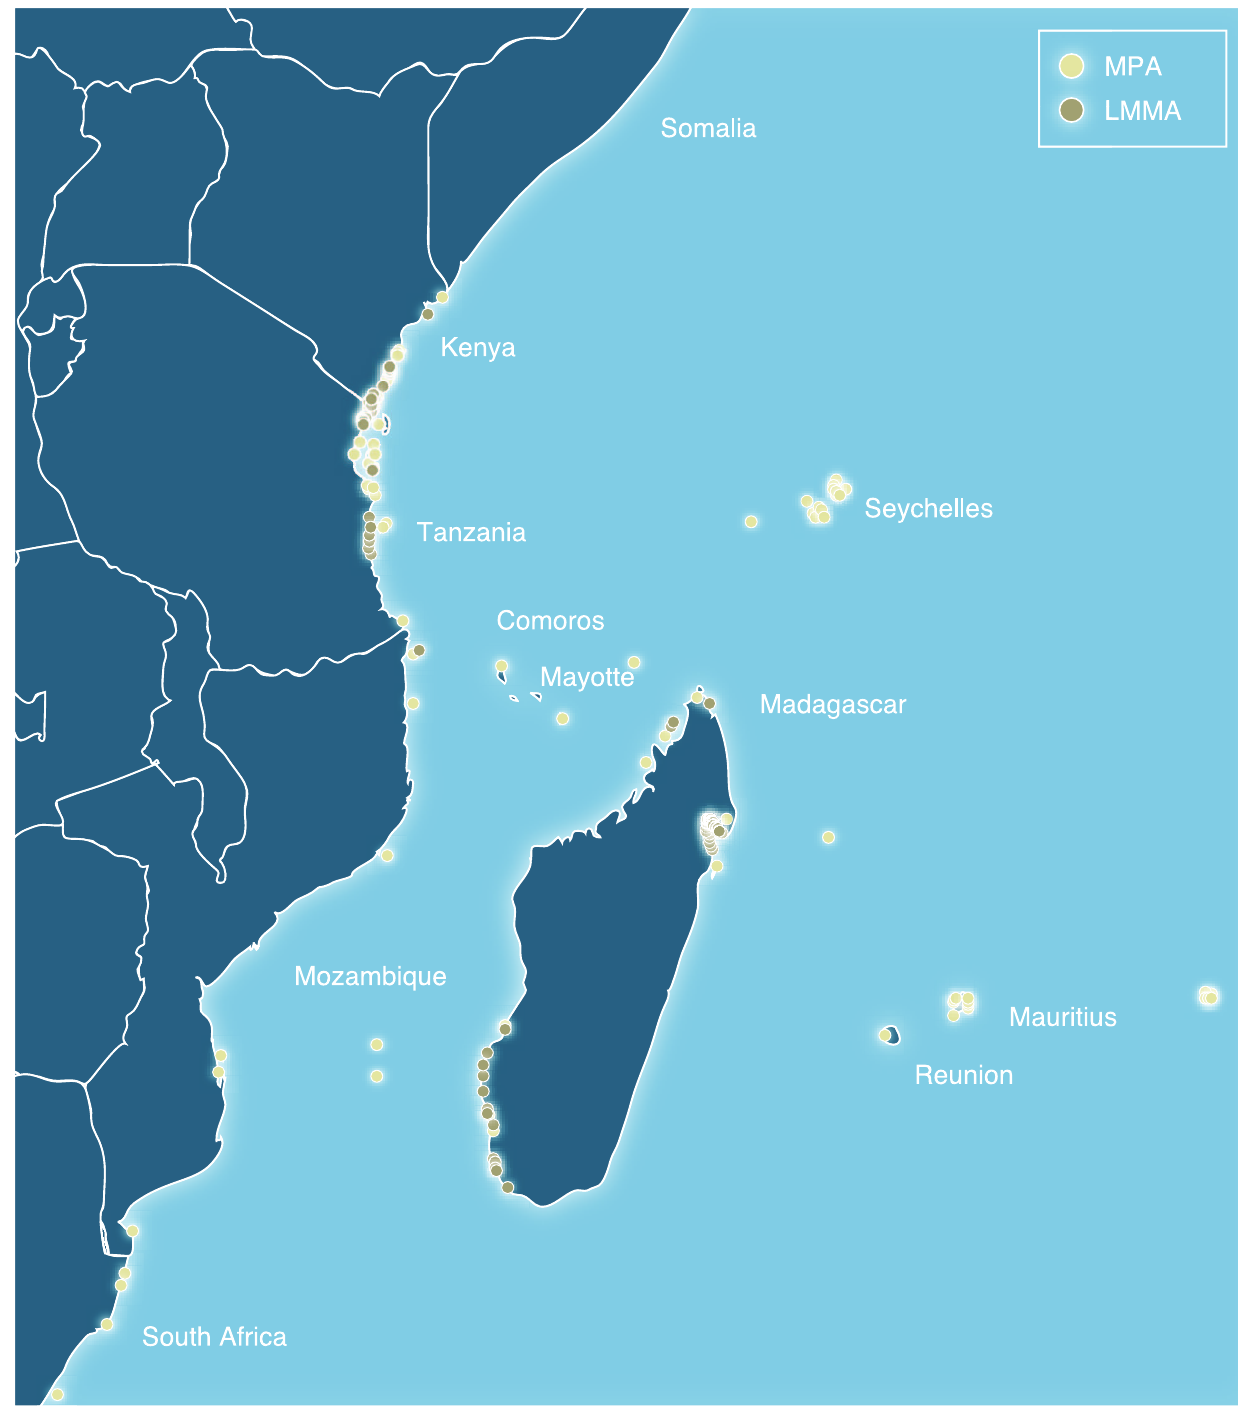
Figure 1. LMMAS and MPAs in the Western Indian Ocean.